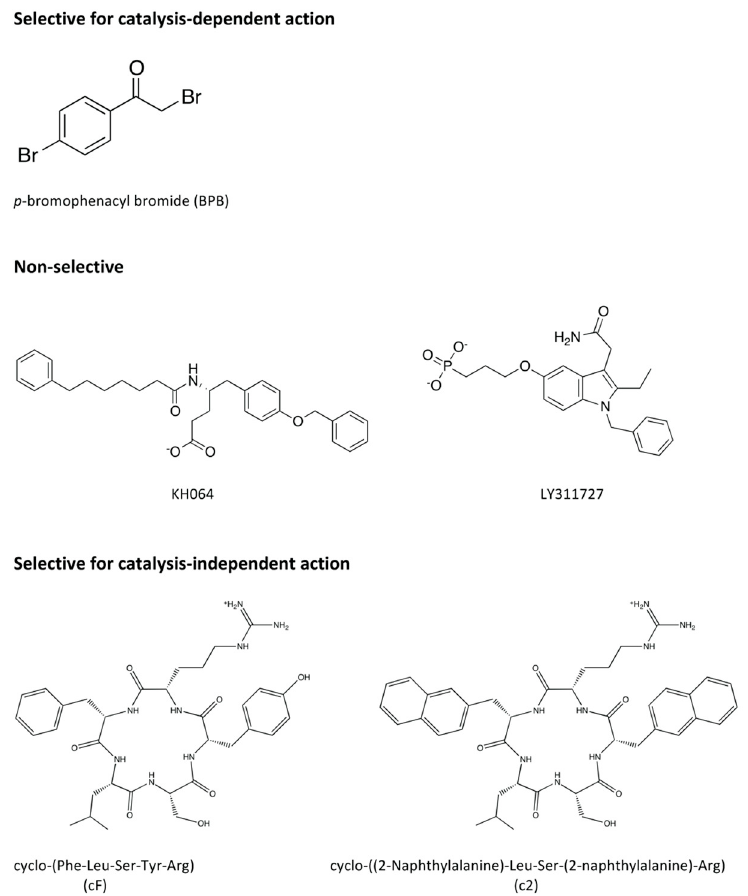
Figure 7. Several hGIIA inhibitors for which classification is known based on their functional mechanism of inhibition.